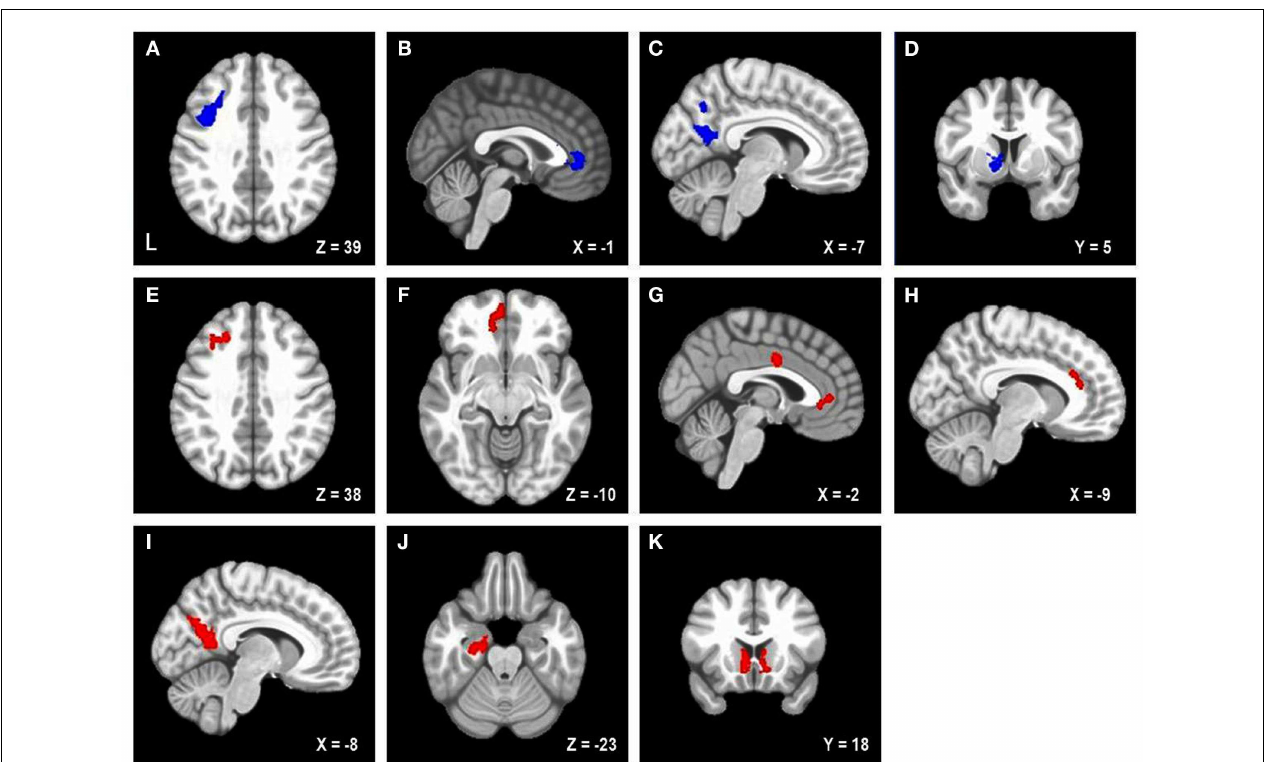
cingulate cortex (rACC), (C) Precuneus, (D) Left caudate, (E) Left mid-DLPFC, (F) Left medial frontal cortex, (G) rACC and posterior dorsal ACC (dACC), (H) dACC, (I) Precuneus, (J) Parahippocampal gyrus, (K) Bilateral nucleus